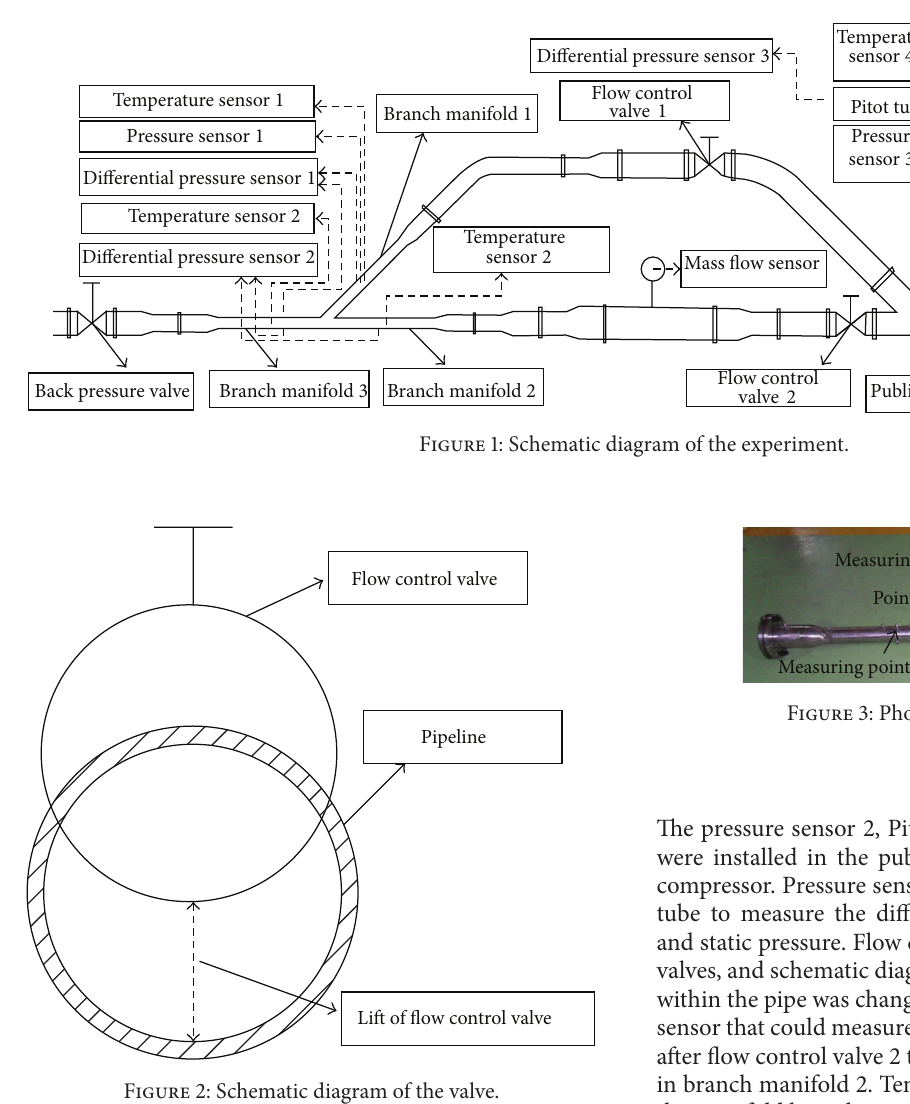
Figure 2: Schematic diagram of the valve.